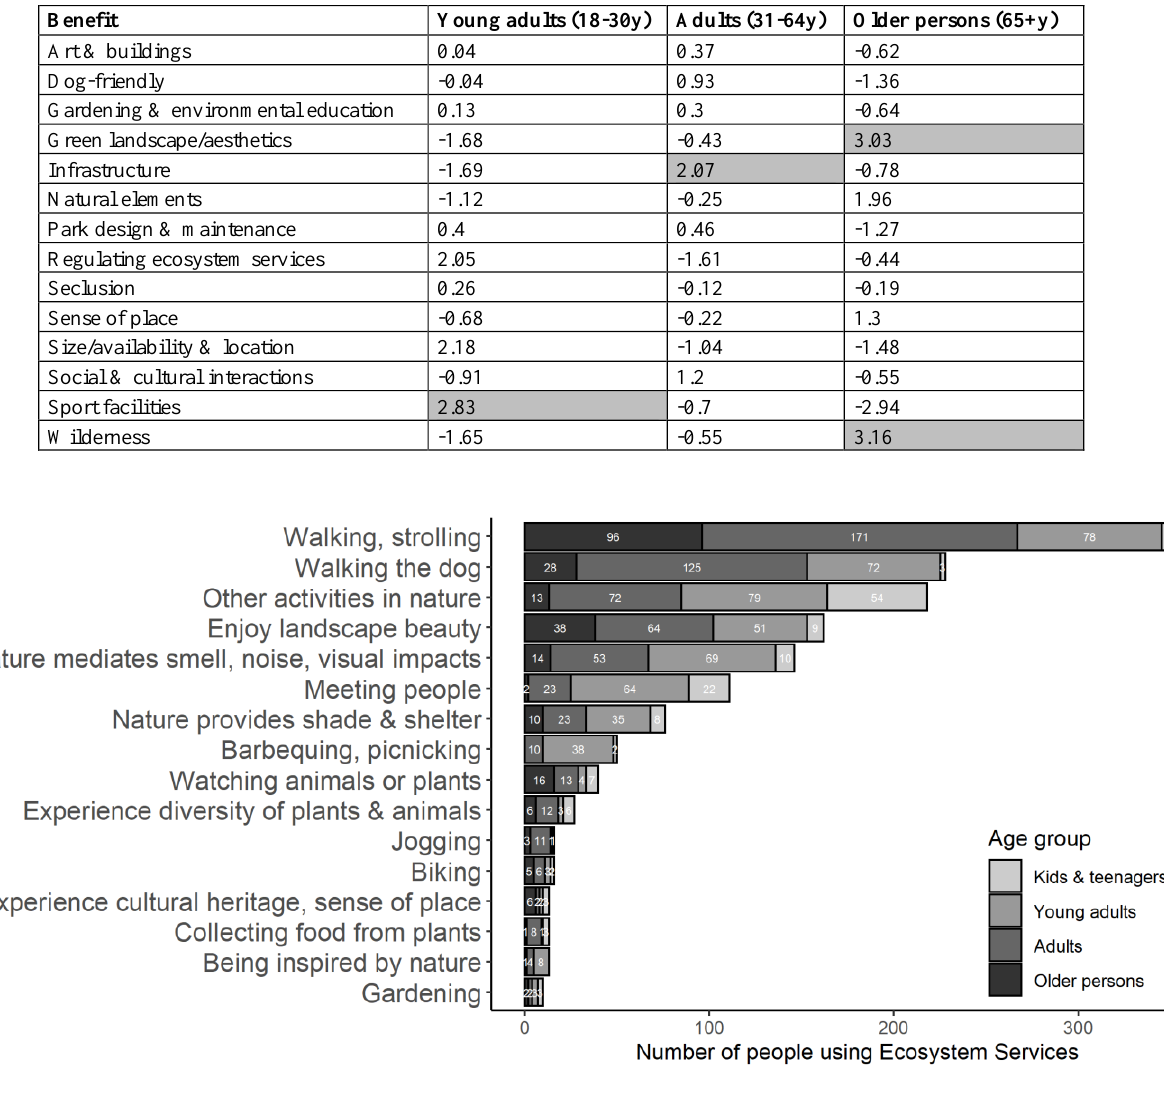
Figure A1.7: Respondents of different age groups from surveys (n=1500) in urban parks and their used ecosystem service (question with predefined ecosystem services). Ecosystem services that were used from less than 10 respondents were aggregated in “Other activities in nature” for graphical